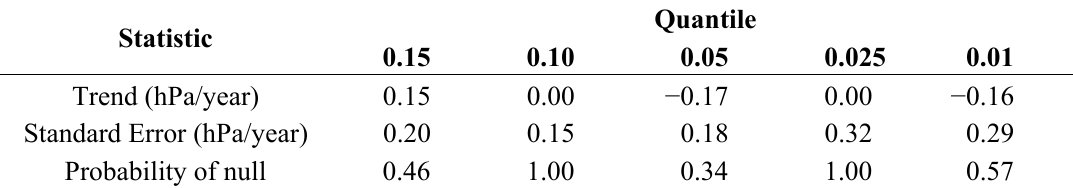
Table 2. Summary statistics for quantile regression 1951–1987.